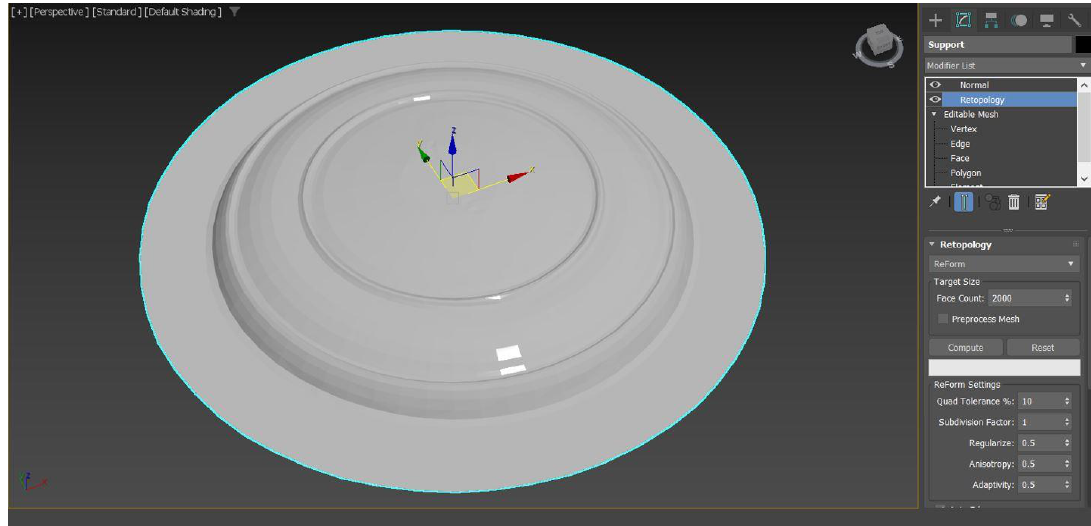
Figure 17. Retopology modifier on the surface of the disk support.